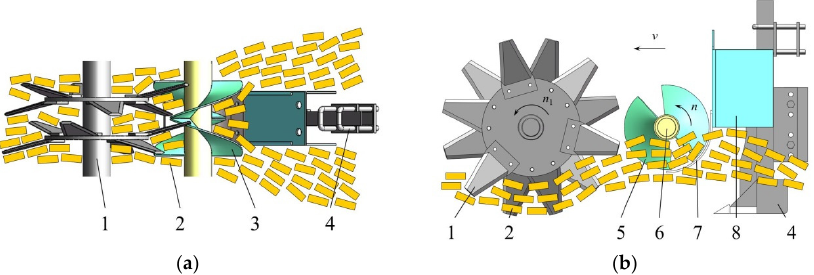
Figure 2. Working principle of SSRSD. ( a ) Vertical view; ( b ) side view. Note: 1, no-till anti-blocking knife; 2, straw; 3, SSM; 4, furrowing opener 5, RB; 6, spiral shaft; 7, straw hopper; 8, straw baffle. v is the operating velocity of machines, km/h; n 1 is the rotary velocity of no-till anti-blocking knife, rpm; n is the rotary velocity of the spiral shaft (RVSS), rpm.